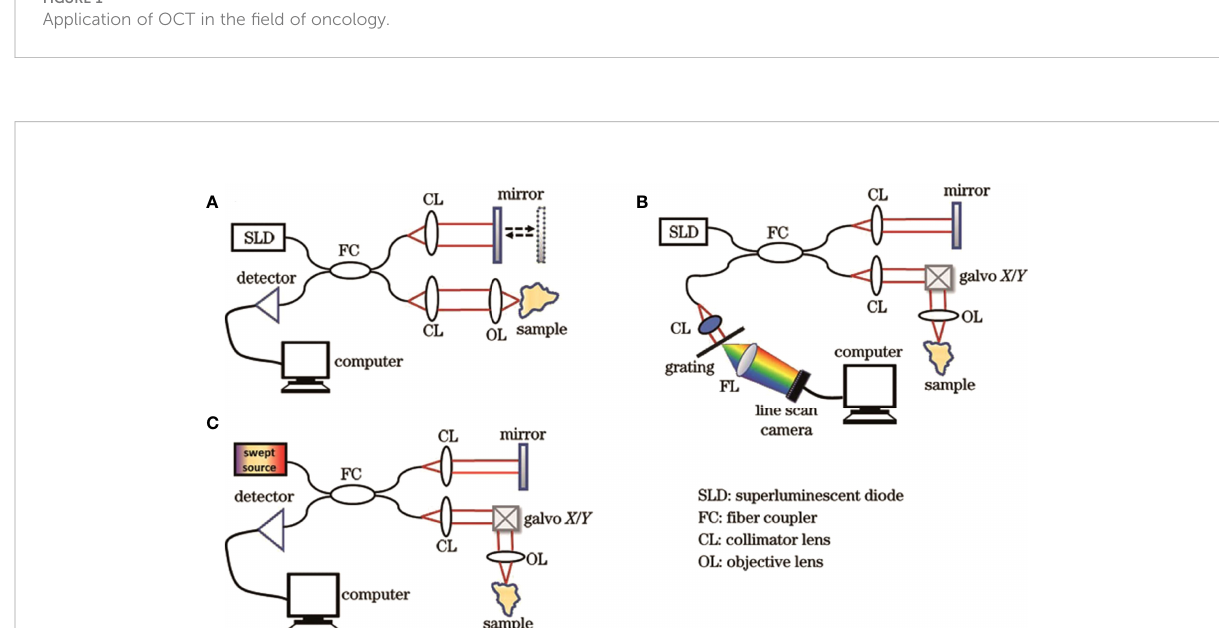
FIGURE 2 Structural diagrams of three generations of OCT systems. (A) TD-OCT; (B) SD-OCT; (C) SS-OCT (30). Copyright 2022,